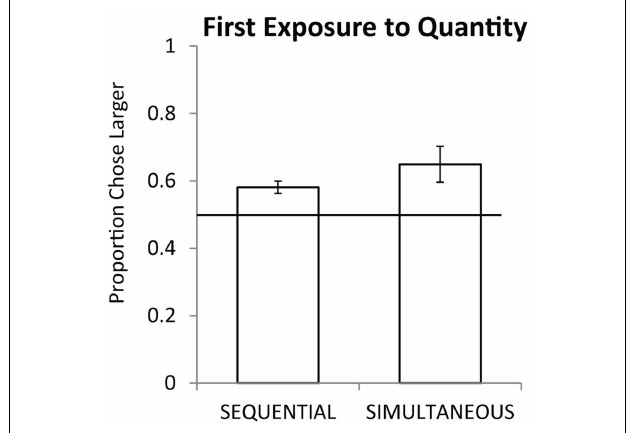
FIGURE 2 |Average accuracy for eight monkeys on sequential and simultaneous trials from their first exposure to numerical discriminations . Chance is a 0.5 probability. Error bars represent the standard error of the mean across monkeys.